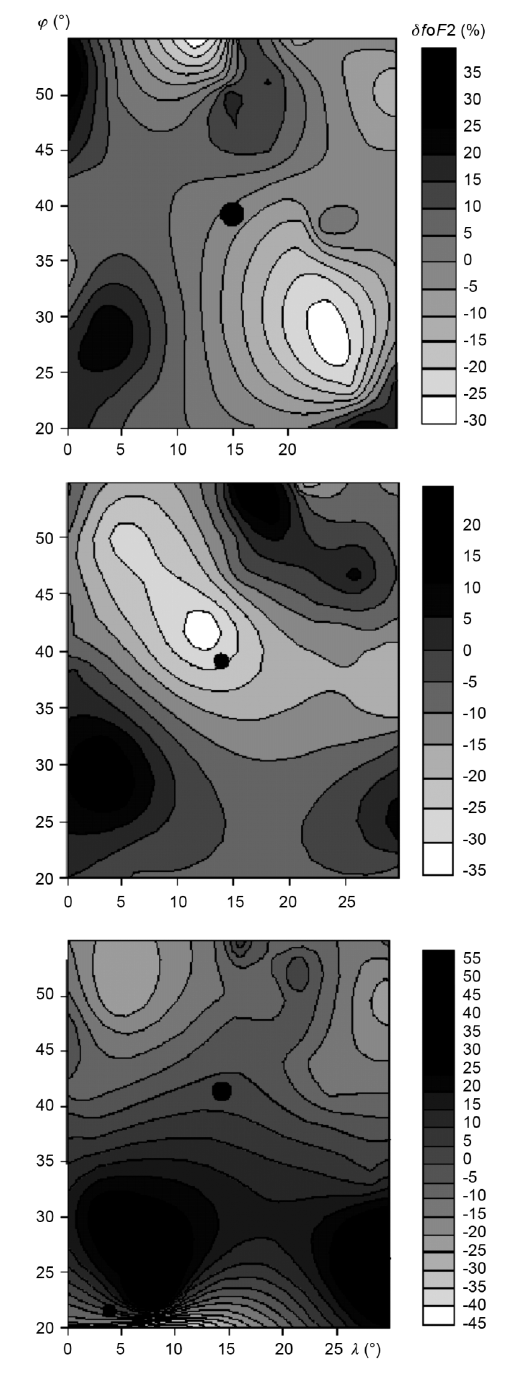
Fig. 5. Dynamics of the modified region in the ion- osphere − 64, − 42 and + 9 h in relation to the Irpinia earthquake seismic shock moment by the data of In- tercosmos-19 topside